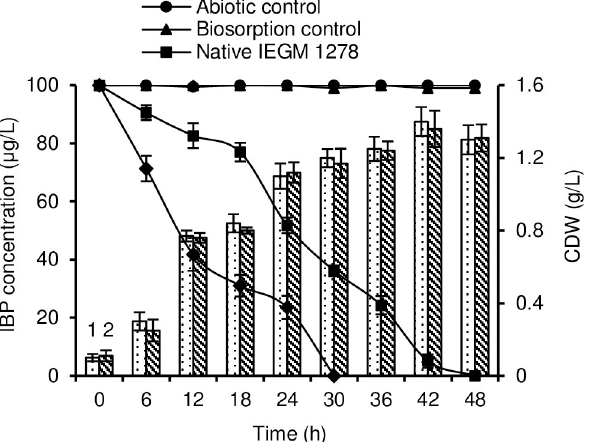
Fig 3. Biodegradation rate of IBP by native and pre-incubated R . cerastii IEGM 1278 cells. 1 –dry weight (CDW) of biomass in the presence of IBP and n -hexadecane; 2 –dry weight of biomass in the presence of n